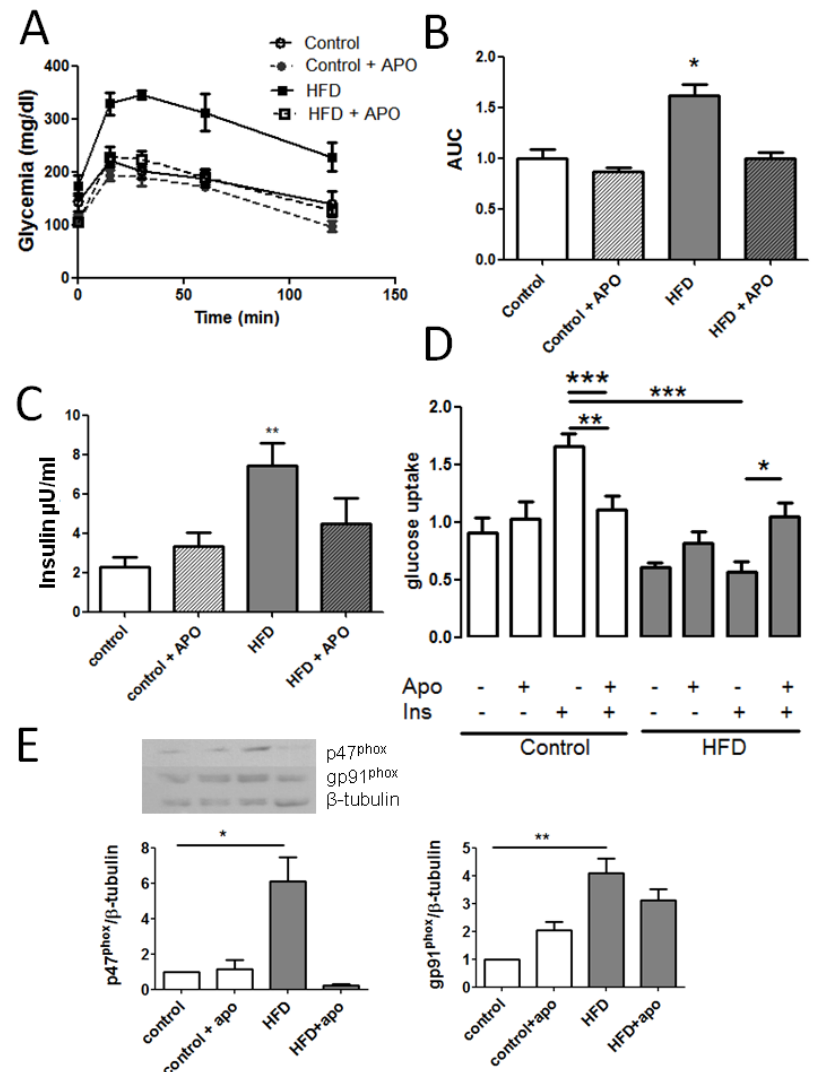
Figure 5. Apocynin prevents insulin resistance in mice. ( A ) Oral glucose tolerance